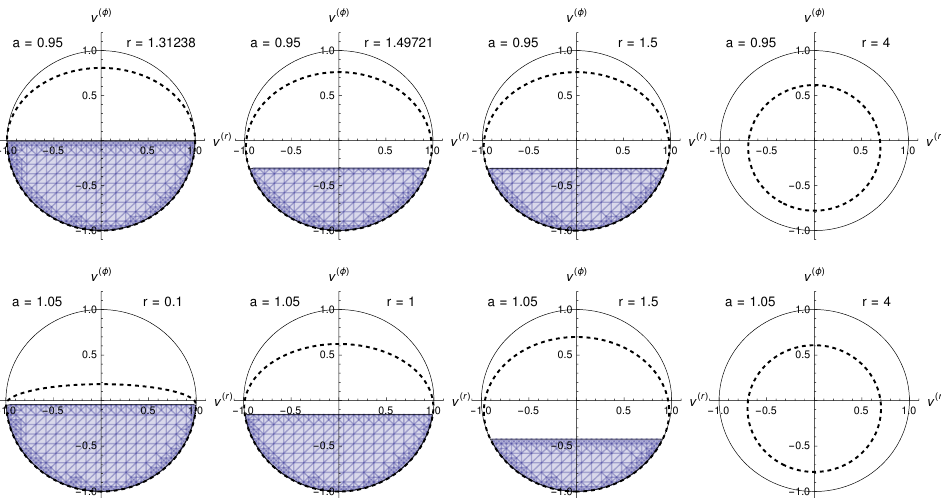
Figure 2. Distribution of different types of the particle equatorial motion in the LNRF velocity space v ( r ) − v ( φ ) . Orbits from shaded regions have negative energy relative to infinity; the thick dashed curves represent last = bounded orbits. The black circle is given by the velocity norming condition. Notice the strong qualitative difference demonstrated in black-hole and naked-singularity spacetimes. The Penrose process is astrophysically plausible for rotating naked singularity because, for near extreme cases, the bound orbits can have negative energy relative to